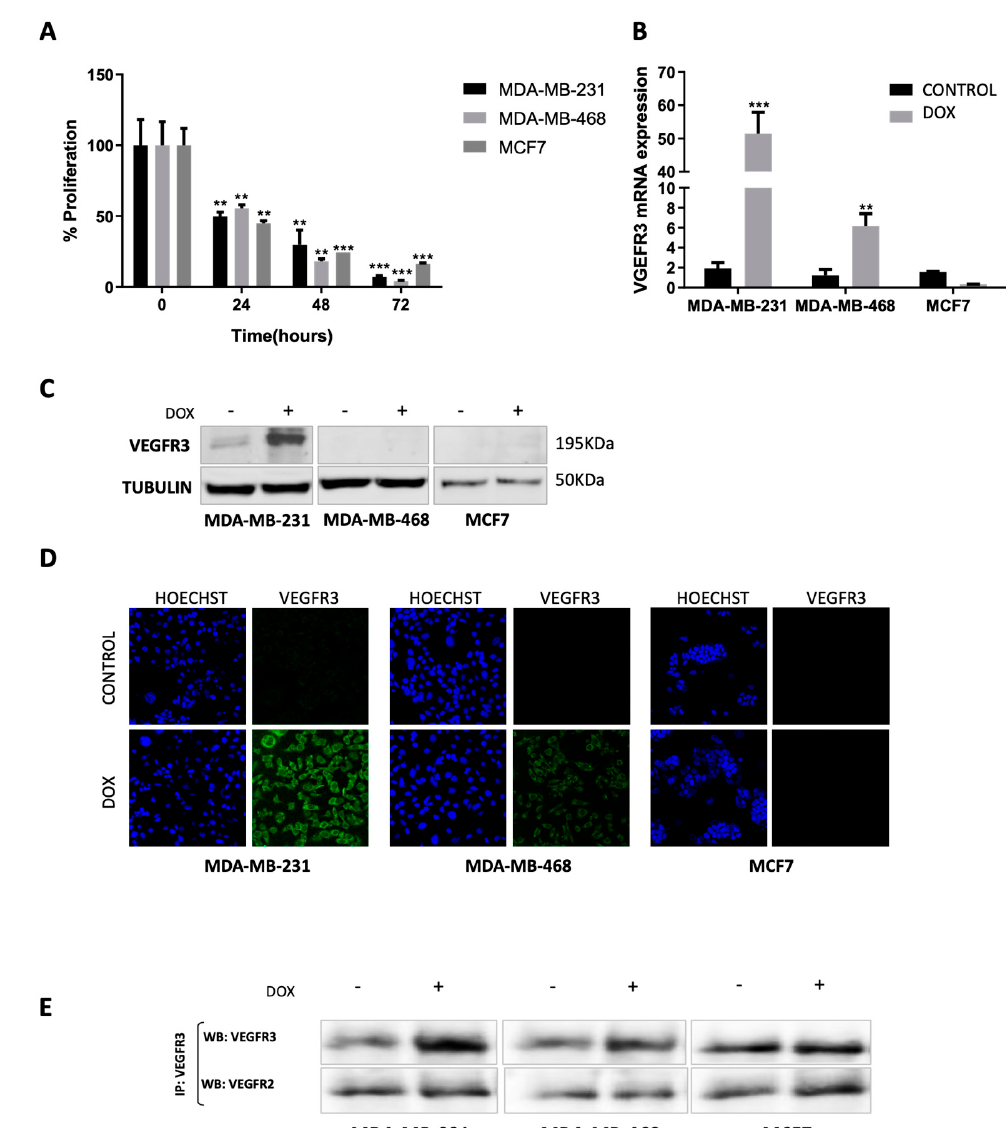
Figure 1. Effect of doxorubicin treatment in MDA-MB-231, MDA-MB-468, and MCF7 breast cancer cell lines. Viability of MDA-MB-231, MDA-MB-468, and MCF7 cell lines after treatment with 5 µ M doxorubicin for 24, 48, and 72 h was measured through MTT assay. The analysis was performed by comparing each time point with the initial one (t0) ( A ). mRNA levels of VEGFR3 at control condition and after treatment with doxorubicin (5 μ M for 24 h) measured by RT-qPCR in MDA-MB-231, MDA-MB-468, and MCF7 cells. GAPDH was used as endogenous gene. The statistical analysis was performed by comparing untreated vs. treated condition in each cell line ( B ). VEGFR3 protein expression with or without 24 h 5 uM doxorubicin treatment was assessed by Western blot in MDA-MB-231, MDA-MB-468, and MCF7 cells. α -tubulin was used as endogenous control ( C ). Representative immunofluorescence images for VEGFR3 (green) and Hoescht (blue) in MDA-MB-231, MDA-MB-468, and MCF7 cells after doxorubicin (5 µ M for 24 h) treatment and control (no treatment) ( D ). Immunoprecipitation with anti-VEGFR3 antibody and Western blot with anti-VEGFR3 and anti-VEGFR2 antibodies in MDA-MB-231, MDA-MB-468, and MCF7 cells ( E ). ** p < 0.01, *** p < 0.001. DOX: